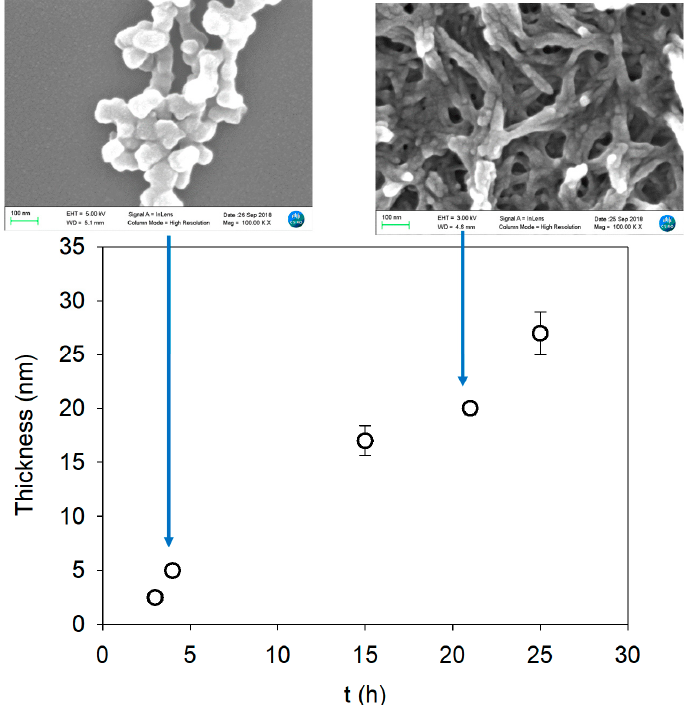
Figure 3. Morphologies of AMN based films obtained by scanning electron microscopy (SEM) after 4.5 h and 21 h of deposition are shown in the upper part and related to the deposition kinetics (lower part) measured by means of single wavelength (632.8 nm) ellipsometry. The deposition was performed using a 10 mg · mL − 1 AMN solution in the presence of 50 mM phosphate buffer at pH = 8.5. The scale bar corresponds to 100 nm in each micrograph. The full image size is about 1 µ m × 1 µ m. Reproduced with permission from [14], Copyright Elsevier,